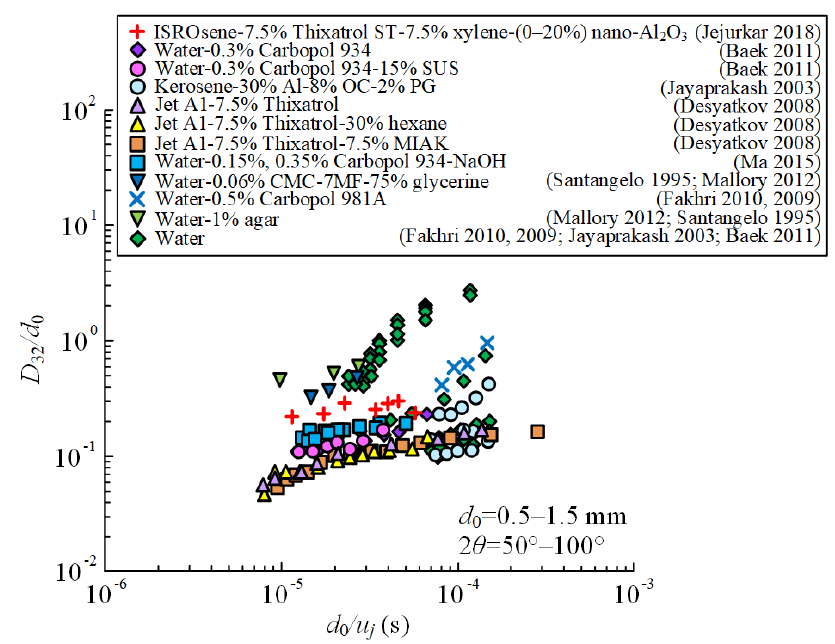
Figure 15. Dimensionless Sauter mean droplet diameters from the parameter of the spraying device ( d 0 / u j ) [69,146,148,149,151,153,168,171,178]